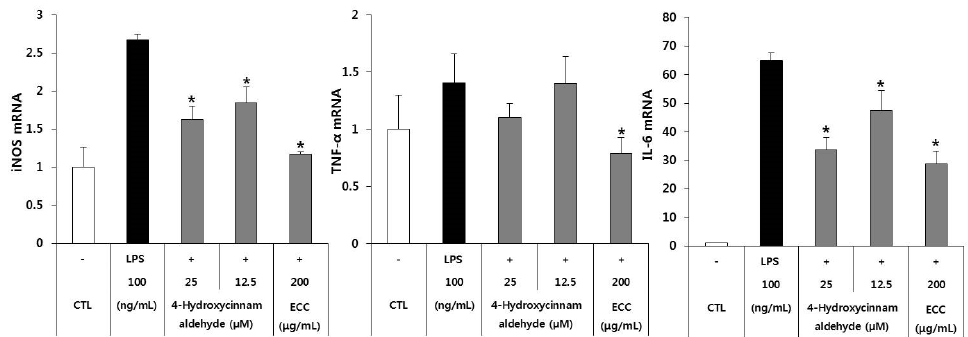
Figure 4. Gene expression of cytokines in RAW 264.7 cells preincubated with ECC or 4-hydroxycinnamaldehyde. The cells were treated with ECC or 4-hydroxycinnamaldehyde for 2 h and